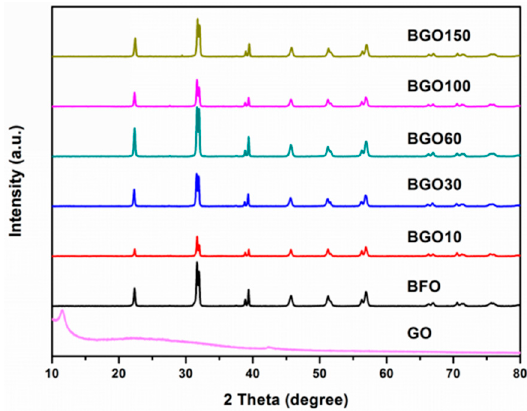
Figure 1. X-ray diffraction (XRD) patterns of Graphene Oxide (GO), bismuth ferrite (BFO) and BiFeO 3 Graphene Oxide (BGO) composites.